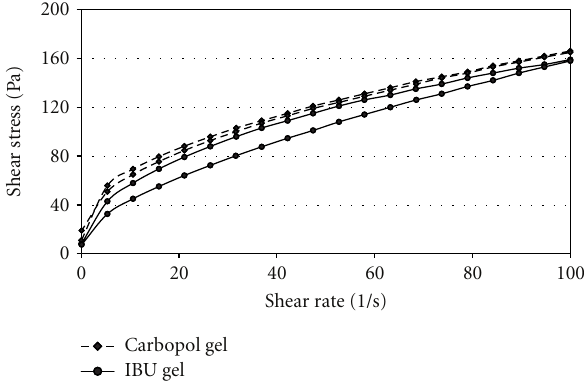
Figure 1: The flow curves of the Carbopol 971 hydrogel (control preparation) and ibuprofen containing